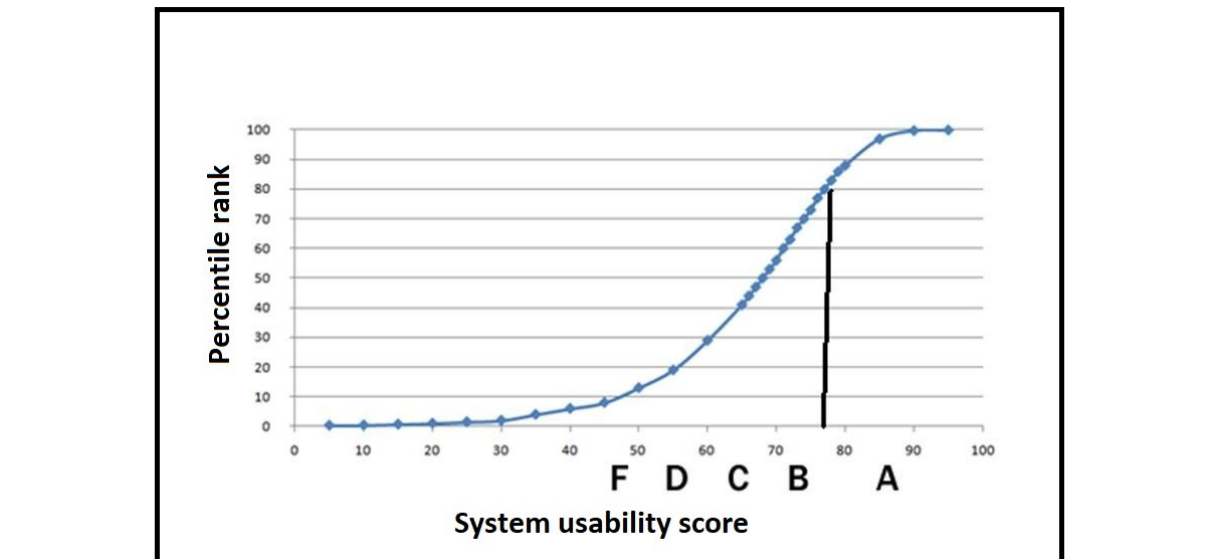
Figure 1. The raw average system usability score of the interactive learning environment on resilience, based on a sample of 20 participants. A, B, C, D, and F are the corresponding letter